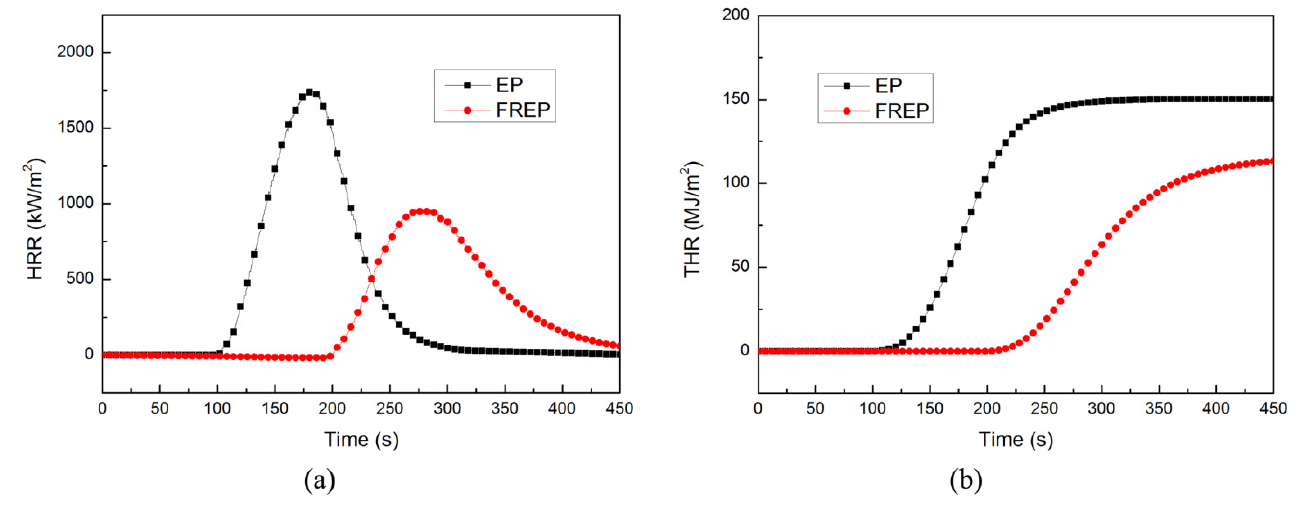
Figure 3. HRR ( a ) and THR ( b ) curves for EP composites.